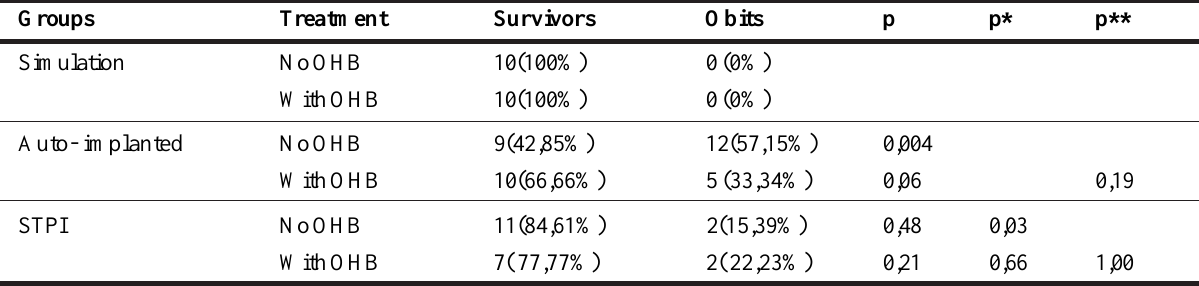
TABLE 1 - Post-operative survival of the different animal groups after 11 days. Groups